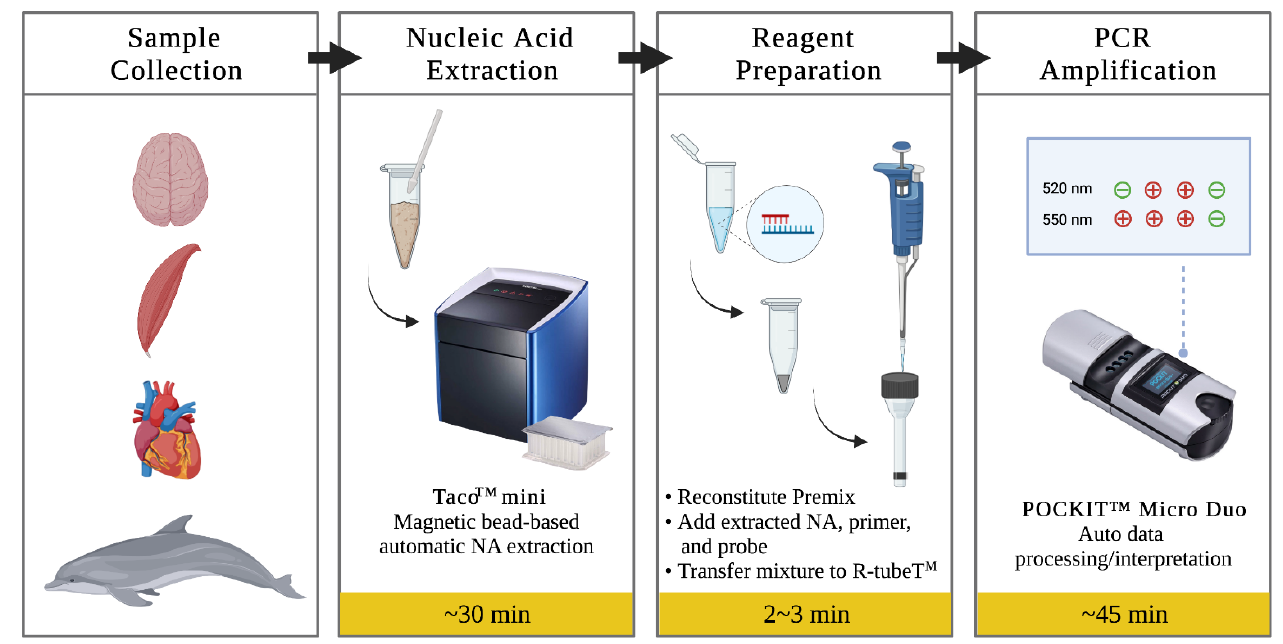
Figure 7. POCKIT™ GeneReach, Lexington, MA, USA) (system workflow for point-of-need detection of T. gondii synthetic spike-in standard. This system includes a compact automatic nucleic acid extraction device (taco™ mini) and a portable PCR device (POCKIT™). After sample collection, nucleic acids are extracted using a preloaded extraction plate in approximately 30 min. Subsequently, the lyophilized iiPCR reaction is reconstituted, and nucleic acids are added and tested. The mixture was transferred to an R-tube and tested in a POCKIT device. TaqMan ® probe hydrolysis-based amplification signals are detected and automatically processed, providing qualitative results on the display screen after 45 min. One to four reactions could be performed simultaneously in one run.